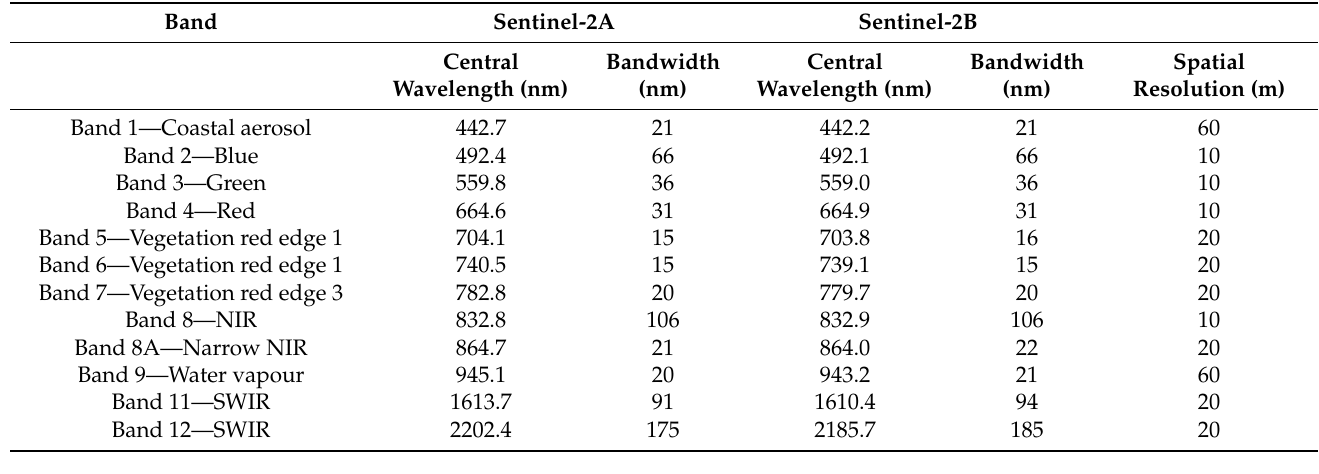
Table 1. The Sentinel-2 bands used in the present study.